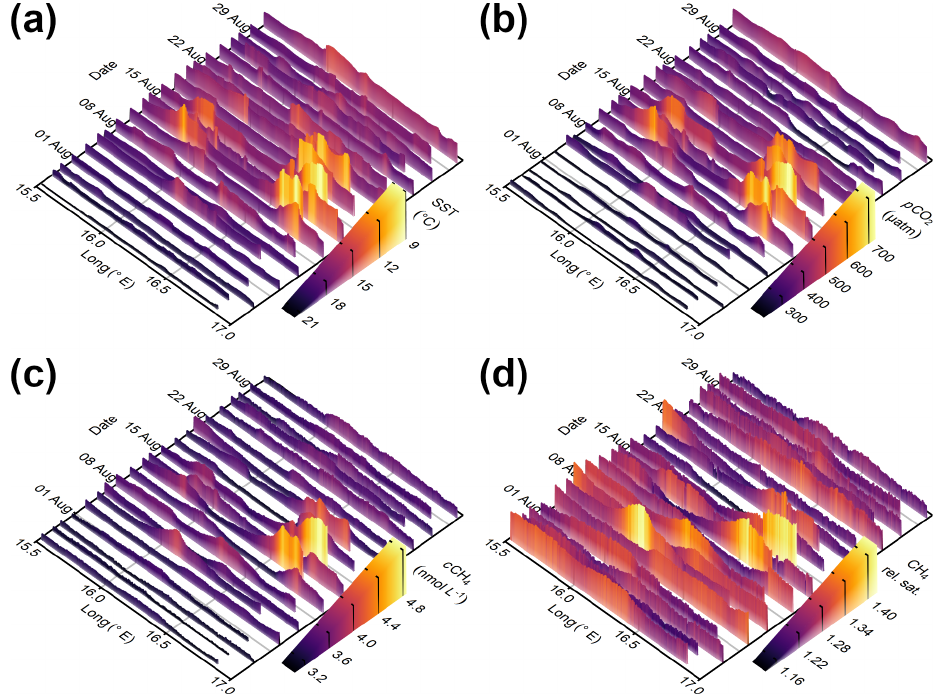
Figure 6. (a) Sea surface temperature, (b) CO 2 partial pressure, (c) CH 4 concentration, and (d) relative CH 4 saturation within the Ö-S box as measured by SOOP Finnmaid on 21 sub-transects from 26 July to 30 August 2016. In all panels, abscissa is position given as longitude, ordinate is time, and the respective variable is displayed by both colour and height of the curve. Please note the inverted SST scale in (a) to highlight the correlation between decreasing SST and increasing p CO 2 and c CH 4 . Data presented in (a–c) correspond to Fig. 7b and